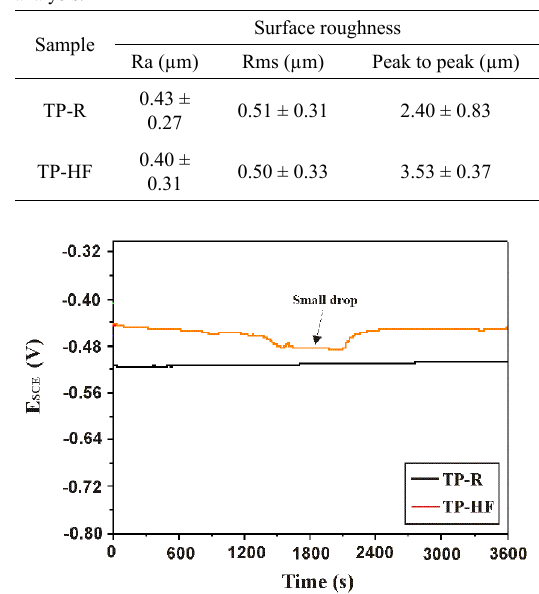
Figure 6. Open circuit potential curves for the filmed substrate (hybrid film) and for tinplate without coating.